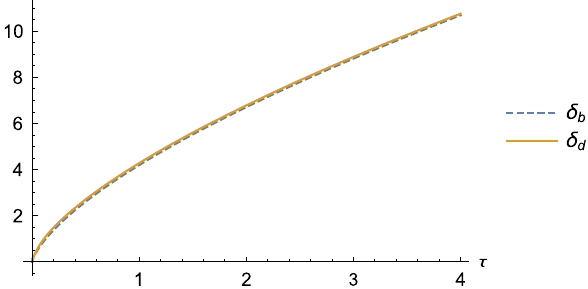
Fig. 3 Density contrasts of baryons δ b and dark matter δ d as functions oftime τ = H 0 t forsmallwavelengthwithrespecttoJeans’wavelength /λ = 50 J